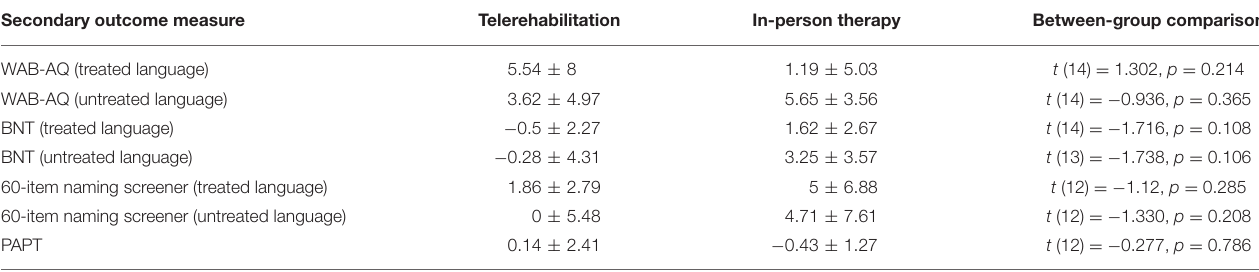
TABLE 5 | Comparisons between the telerehabilitation and the in-person therapy groups on treatment-related change scores on secondary outcome measures in the treated and the untreated language. Secondary outcome measure Telerehabilitation In-person therapy Between-group comparison WAB-AQ (treated language)